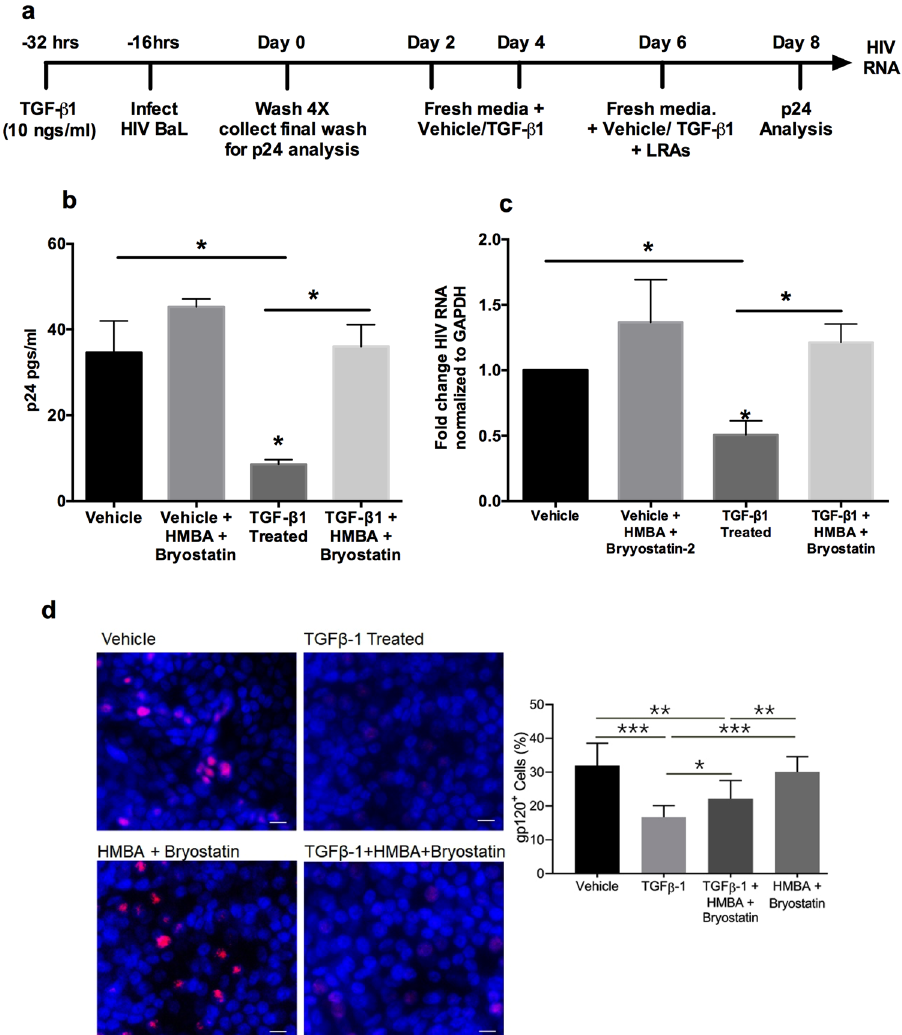
Figure 1. TGF- β 1 promotes HIV latency in NHBE cells. ( a ) Experimental timeline for effect of TGF- β 1 on HIV infection. ( b ) NHBE cultures redifferentiated at the ALI were treated and infected as shown in ( a ). Culture supernatants were collected on day 8 for post-reactivation p24 analysis using p24 ELISA kit. ( c ) Total RNA was isolated and HIV transcripts were quantitated by qRT-PCR. TGF- β 1 treatment suppresses HIV mRNA and this can be reversed with the combination of LRAs Bryostatin-2 and HMBA. TGF- β 1 suppresses viral p24 and this corelates well with mRNA suppression. n = NHBE ALI cultures from at least 5 different lungs; * p < 0.05. ( d ) The TGF- β -mediated suppression of gp120 expression levels in HIV-infected and latency reactivated NHBEs, scale – 10 µ . n = NHBE ALI cultures from 3 different lungs, * p <